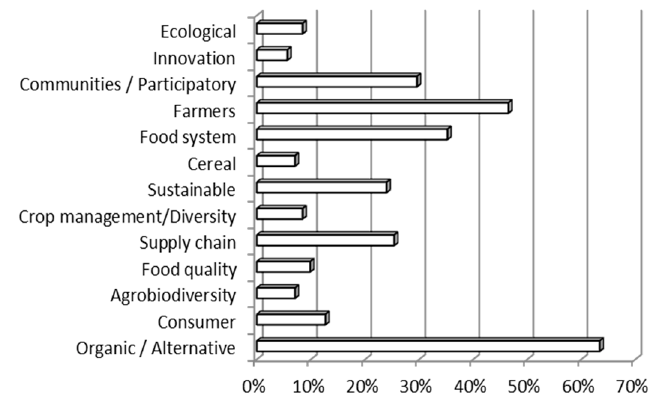
Figure 3. Number of included papers by topic.